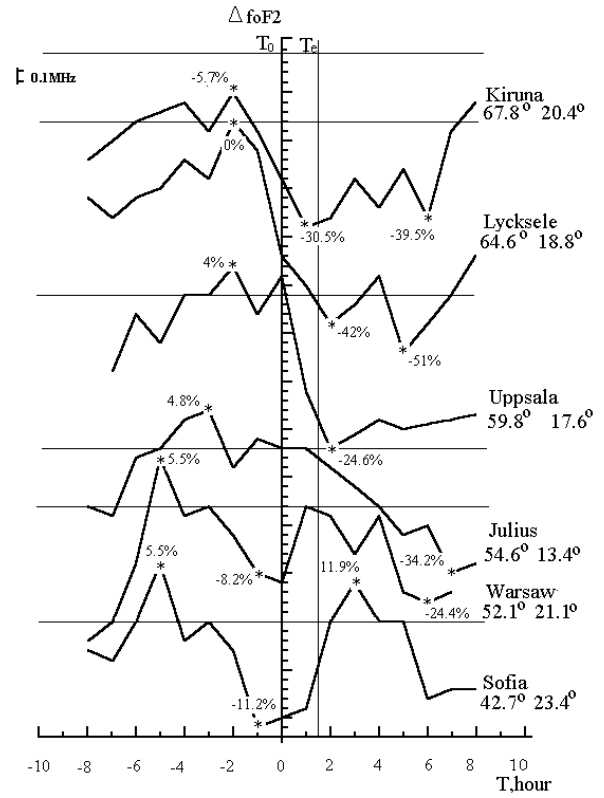
Fig. 9. The variations of 1 fo F2 values for the positive substorm that occurred on 05 March 1999 ( T o = 16:00UT or 18:00LT, I = + 220nT, τ = 1 . 5h) through the first (northern) longitudinal chain of stations of the IDCE, LT = UT + 2. The vertical lines mark substorm onset, T o , and the end of the substorm, T e . Asterisks are δ fo F2 (%)